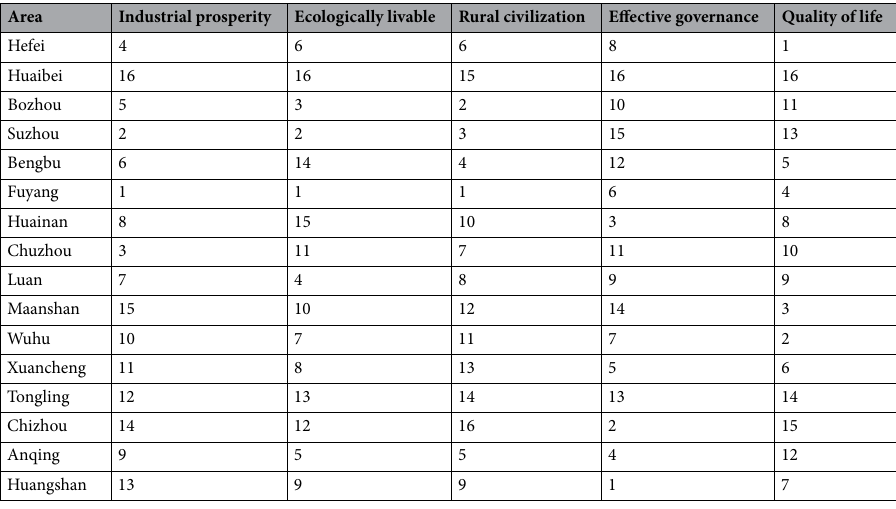
Table 4. Ranking results in five aspects of Anhui province.